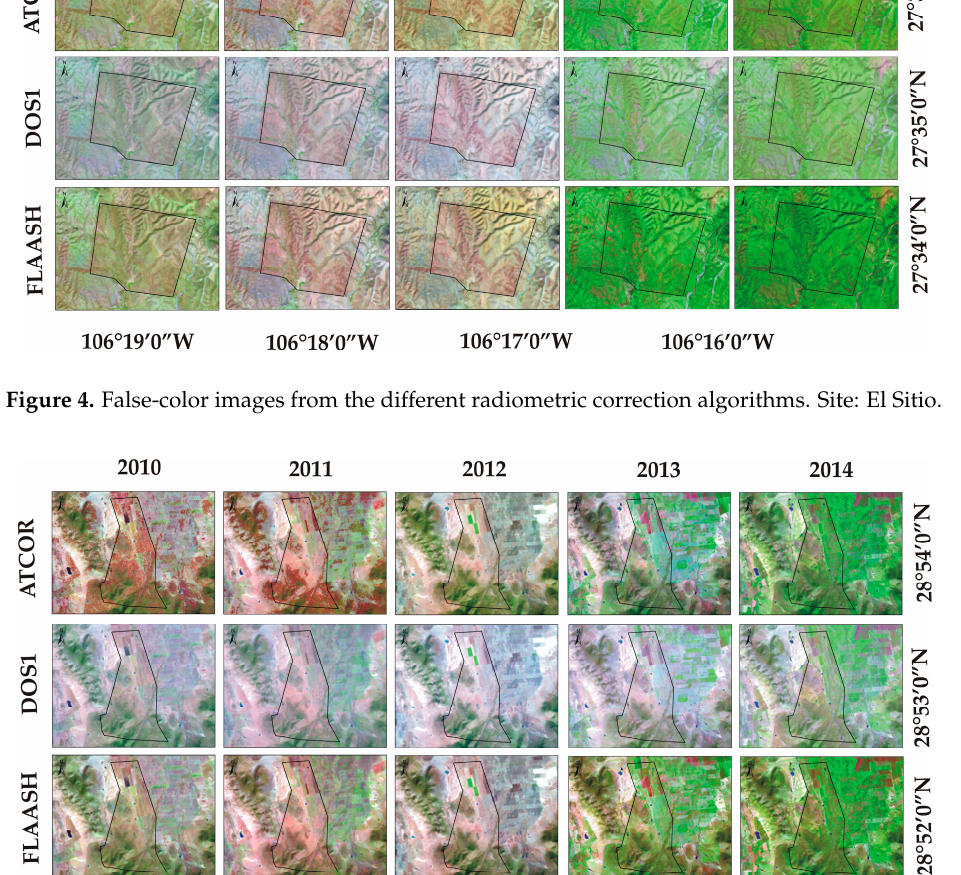
Figure 5. False-color images from the different radiometric correction algorithms. Site: Teseachi.